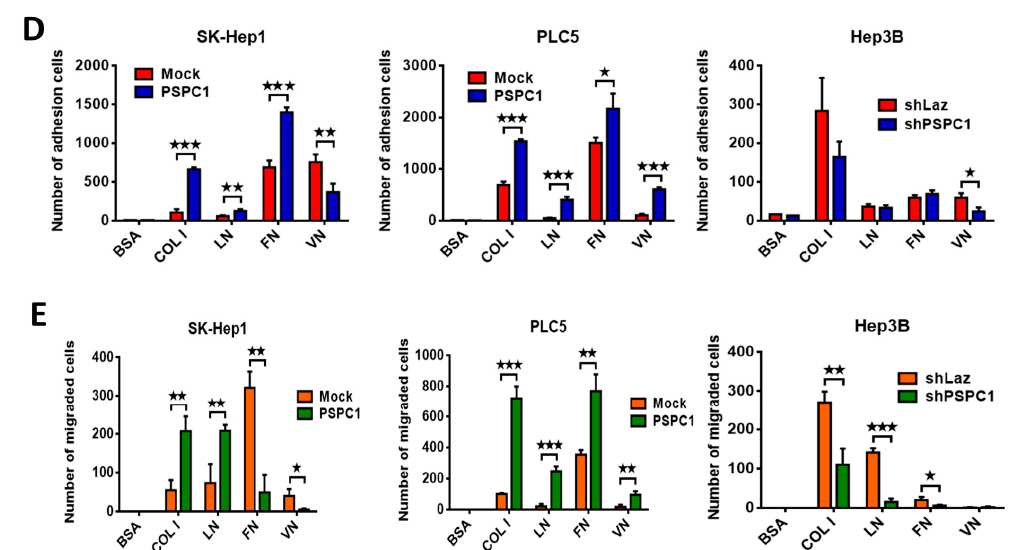
Figure 2. PSPC1 modulates FAK and Src kinases activity to promote cell adhesion and motility on extracellular matrix. ( A ) Phospho-kinase array was performed by using protein lysates of PSPC1-expressing SK-Hep1 cells. ( B ) Expression of phosphorylated FAK (Y397 and Y576 / 577) and Src (Y416) with their total proteins was investigated in three PSPC1-modulated HCC cells by Western blotting analysis. ( C ) Colocalization of phospho-Paxillin (green) and Talin1 / 2 (red) by double immunofluorescence staining in three HCC cells. Scale bars: 5 µ m. ( D ) PSPC1-overexpressing and knockdown cells were seeded with serum free medium and plated into ECM coating cells of 96-well plate (COL I: collagen type I, LN: laminin, FN: fibronectin, VN: vitronectin) for 30 min. Adhered cells were counted in full field. ( E ) Capability of cell migration toward ECM were measured using Boyden chamber assay coated with ECM for 20 h in three PSPC1-modulating HCC cells. Data are shown in mean ± SD analyzed by paired and two-tailed t -test, n = 3 per group, p -values (* p < 0.05; ** p < 0.01; *** p <